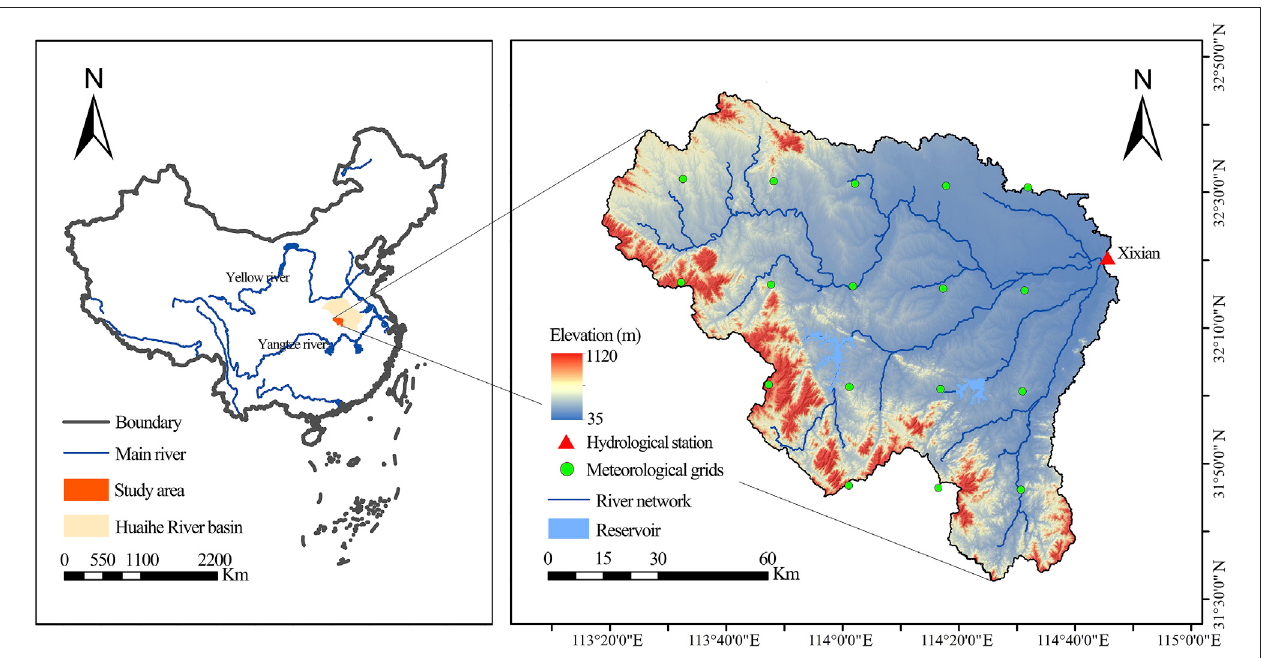
FIGURE 1 | Location, topography, and river network of the upper Huai River basin, and the distribution of meteorological grids and hydrological stations.